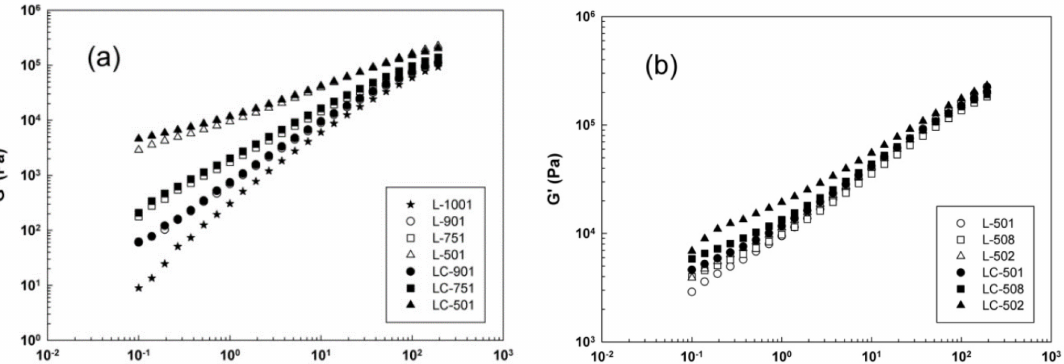
Figure 20. Dynamic elastic modulus as a function of angular frequency to determine the effect of: ( a ) RTF content, and ( b ) extruder screw speed